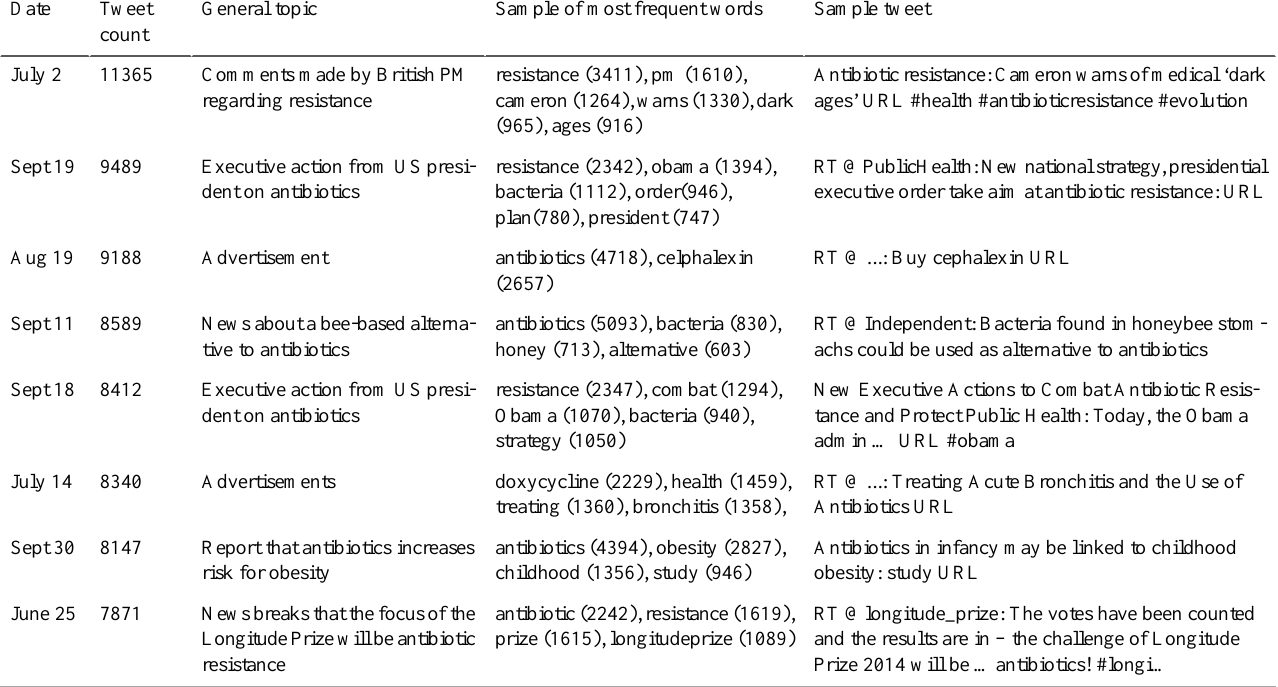
Table 2. Dates with unusually high tweet count along with rationale for activity.